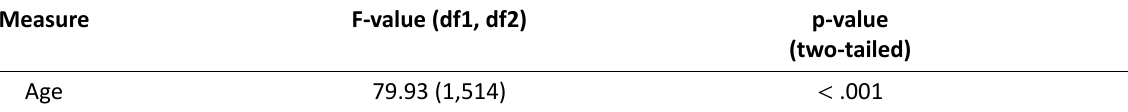
Table A2. Regression values between League of Legends MMR and age.